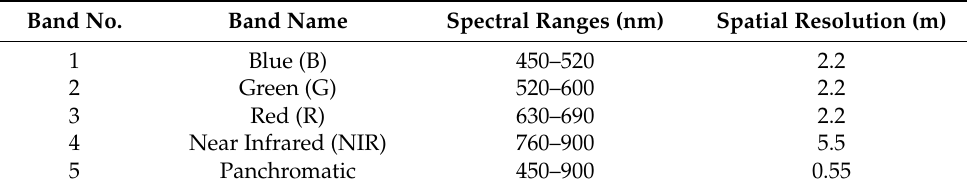
Table 1. Spectral Bands of Korea Multi-Purpose Satellite (KOMPSAT)-3A.